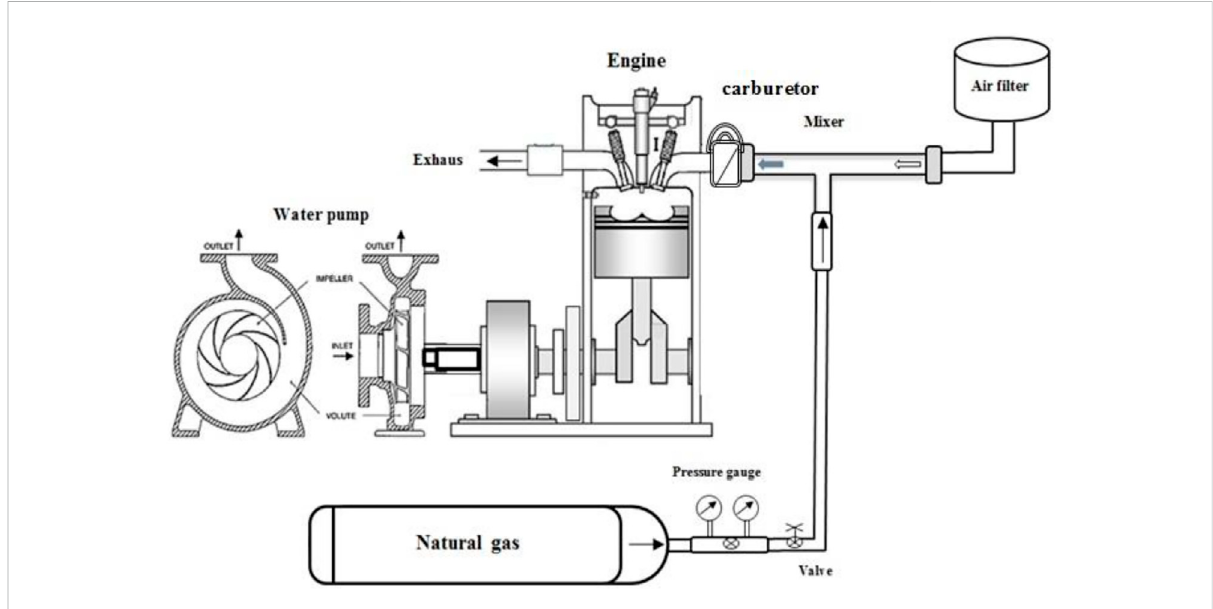
FIGURE 3 Simpli fi ed diagram of a natural gas engine for powering a water irrigation pump.